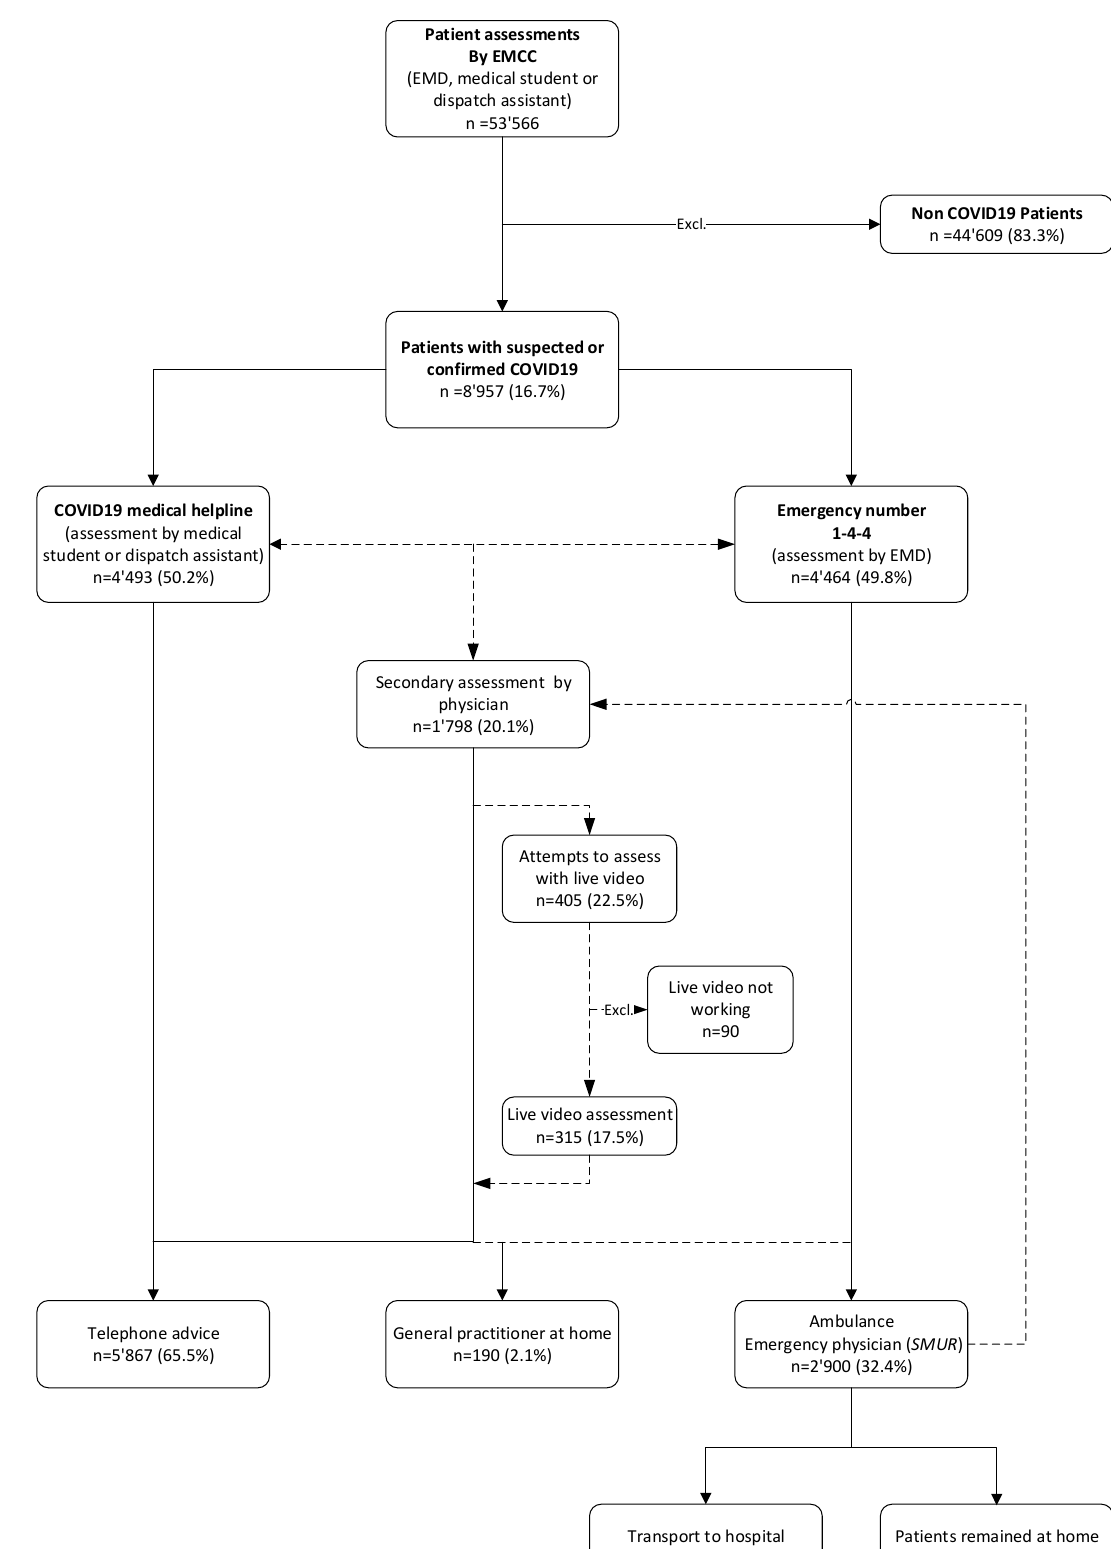
Figure 2. Emergency patient assessment flowchart (1 April 2020–31 April 2021) (solid arrows show frequent decisions or routine actions, whilst dashed arrows show less frequent decisions or possible but more unusual actions).